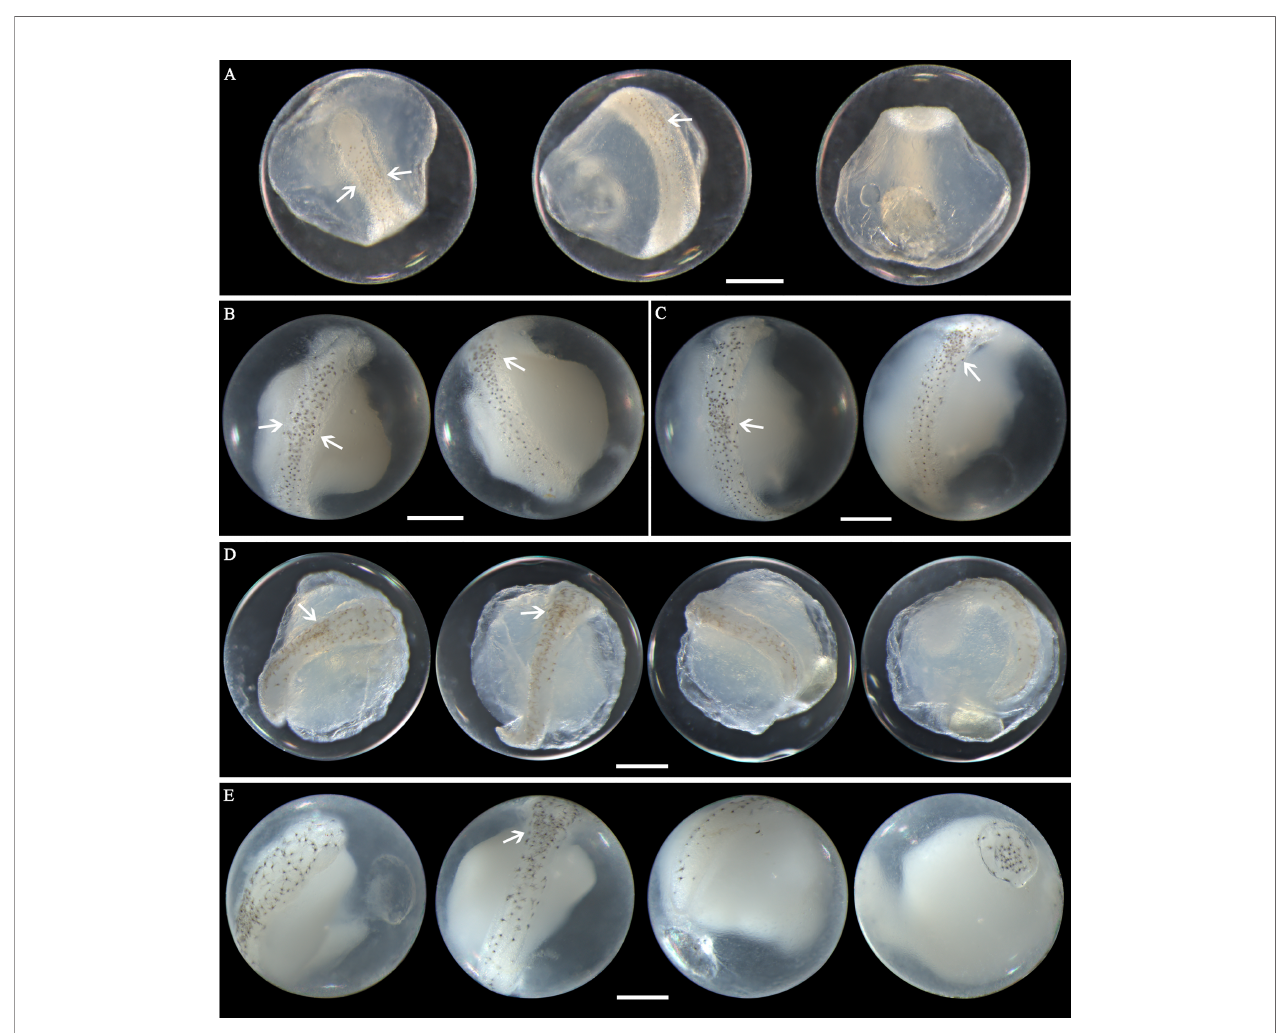
FIGURE 6 | Images of Nibea albi fl ora eggs (A) fi xed in formalin at early middle stage, (B) fi xed in ethanol at middle stage, (C) fi xed in ethanol at middle stage, (D) fi xed in formalin at late stage, and (E) fi xed in ethanol at late stage. Arrows indicate pigment clustering area on embryo. Images within each panel represent the same egg photographed from different observation views. Scale bar for images =200 m